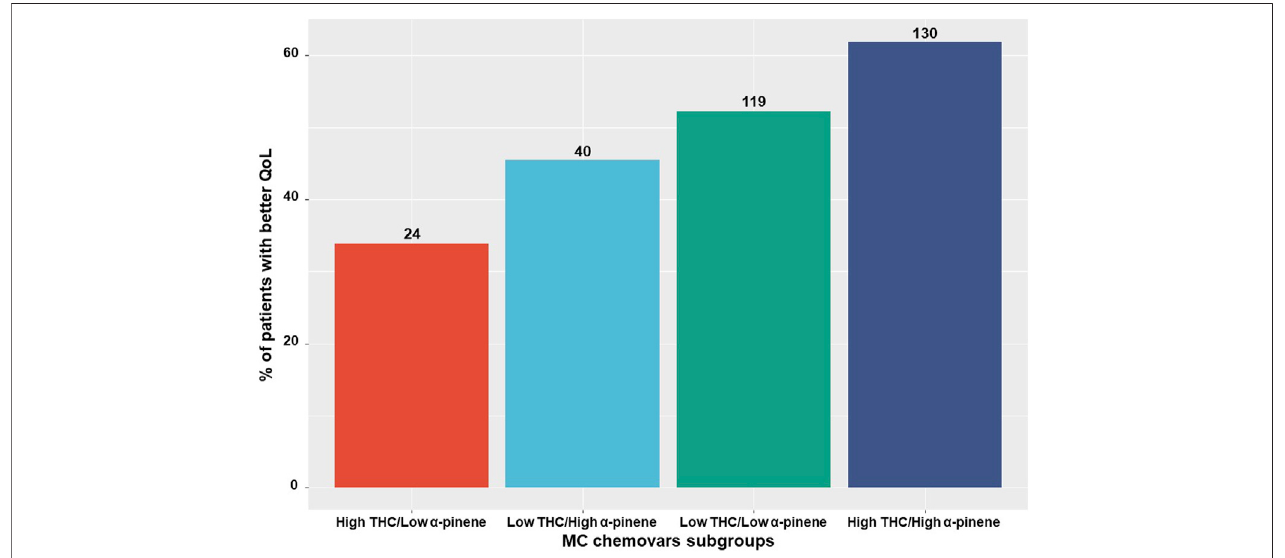
FIGURE 6 | MC chemovar related quality of life reports Subgrouping of the consumed medical cannabis chemovars into low/high THC and α -pinene relative to patients ’ reportson ’ better ’ qualityoflife.QoL,Qualityoflife;THC, Δ 9-trans-tetrahydrocannabinol;MC,medicalcannabis;Numbersonthebarsrepresentthenumberof